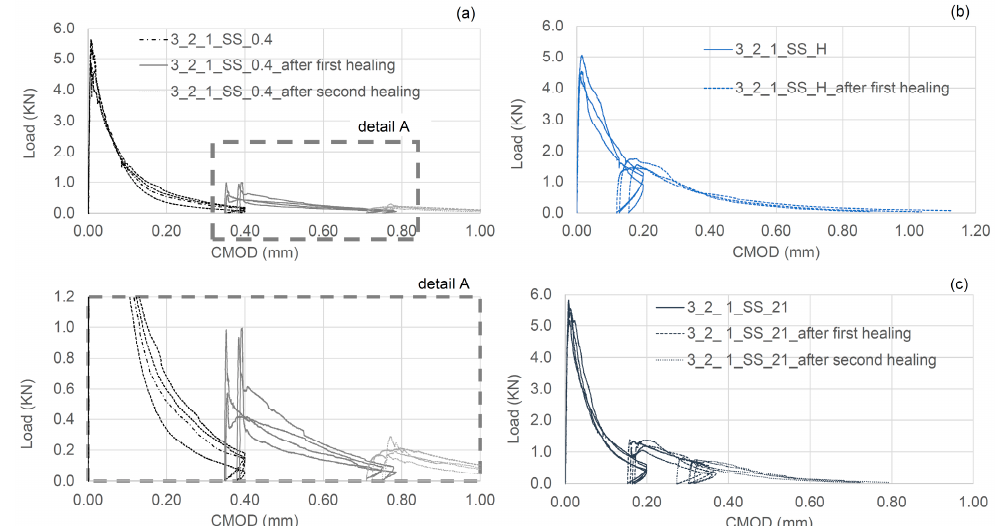
Figure 13. Group 3: ( a ) Flexural load-CMOD response for specimens containing 2 TETs, CMOD = 0.4 mm; ( b ) Flexural load-CMOD response for specimens containing 2 TETs filled with SS cured in high moisture conditions; ( c ) Flexural load-CMOD response for specimens containing 2 TETs filled with SS and stored for an extended healing period. Table 6. Group 3: Flexural test results, indices of healing for two damage-healing cycles. 1 st Healing Cycle 2 nd Healing Cycle